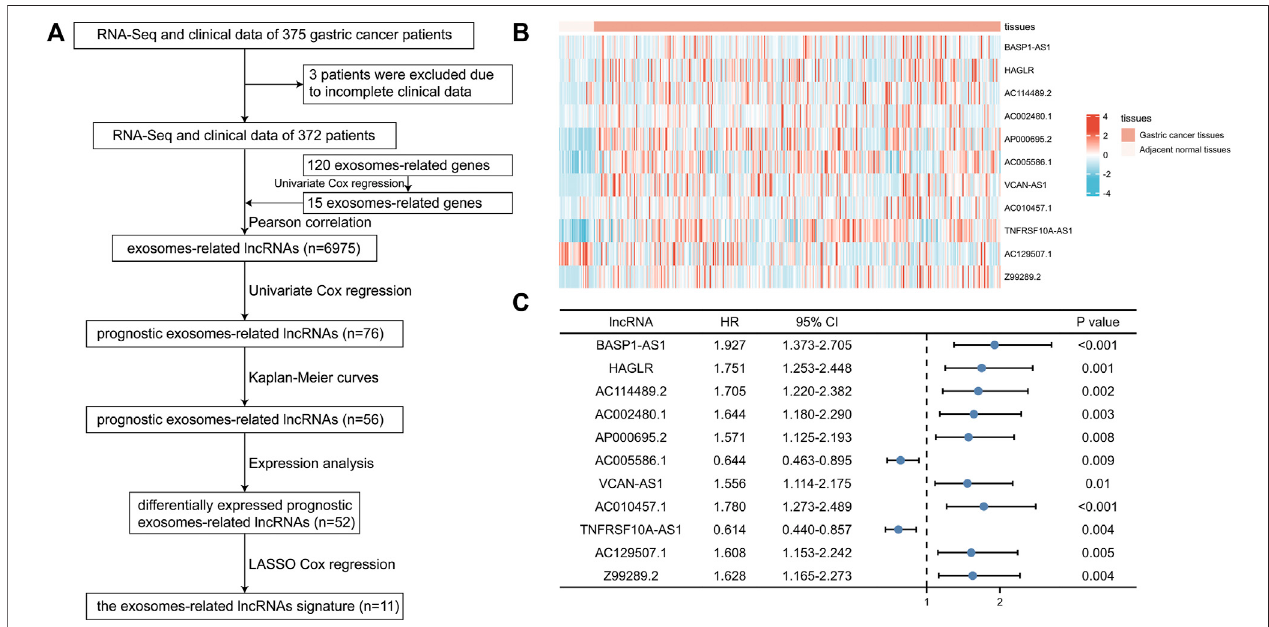
FIGURE 1 | Identi fi cation of prognostic exosomes-associated lncRNAs in gastric cancer (GC) patients. (A) The fl ow chart of constructing the exosomes-related lncRNAs signature. (B) The heatmap of 11 prognostic exosomes-related lncRNAs in GC tissues and adjacent normal tissues. (C) Univariate Cox regression of 11 prognostic exosomes-related lncRNAs. * p < 0.05; ** p < 0.01; *** p < 0.001.